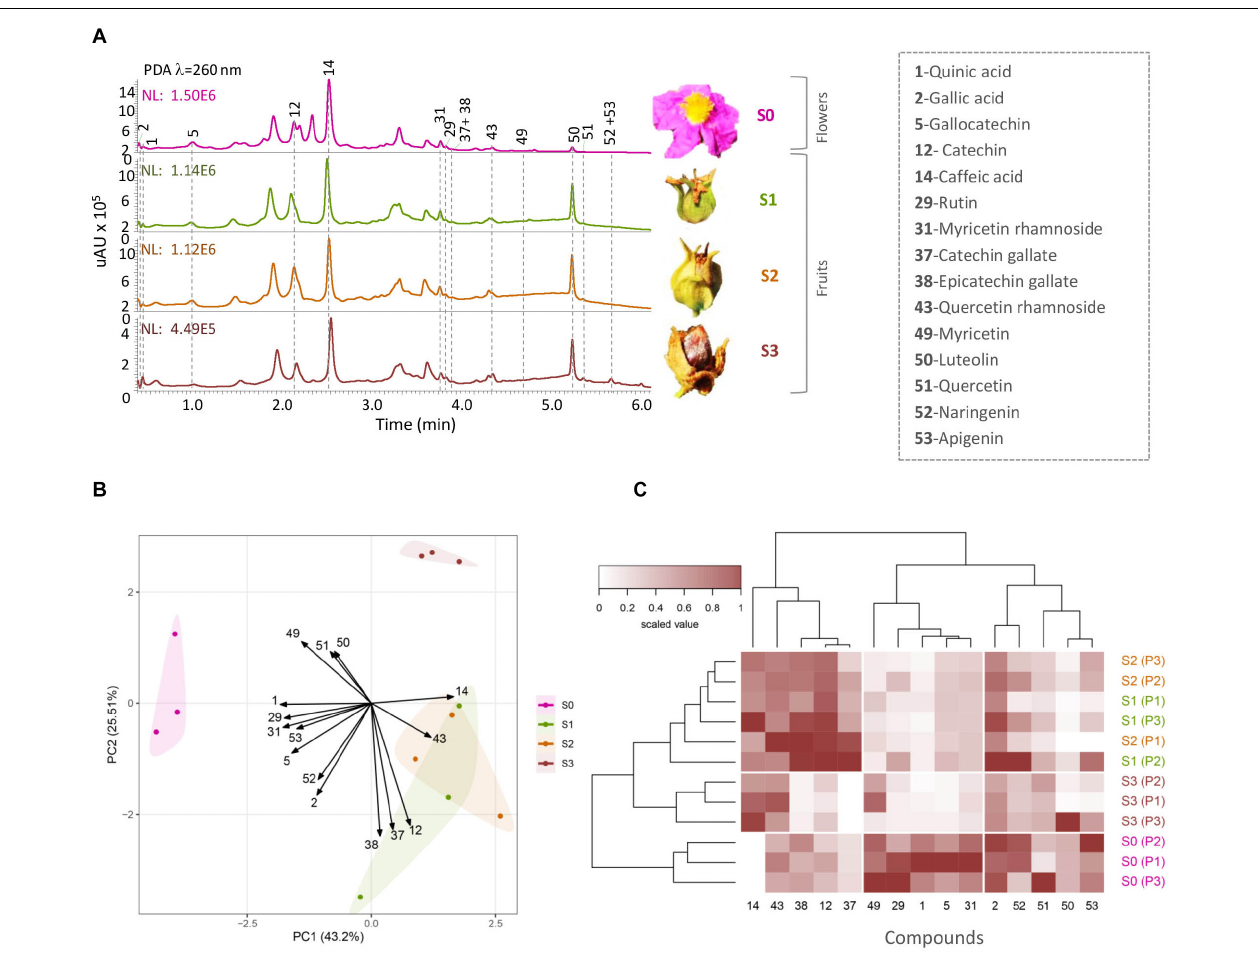
FIGURE 2 | Metabolic profiling of Cistus flower (S0) and three fruit stages (S1–S3). (A) HPLC/DAD elution profiles at λ = 260 nm; notable peaks are denoted in the legend on the side. The Y -axis scales are different for each of the chromatograms. (B) Biplot of principal component analysis performed on zero-centered and unit-scaled compound quantity data. The samples are colored by stage (S0–S3) as shown in the legend, and these groups are further encircled by a convex hull of the same color. Variable loadings are indicated by arrows and were scaled by multiplying with five prior graph constructions so they could be seen more readily. (C) Heat map of zero-centered and unit-scaled compound quantity data. The samples (in rows) are arranged according to hierarchical cluster analysis (Ward’s method of cluster agglomeration) constructed using Euclidean distances (left tree), and the metabolites (in columns) are arranged according to hierarchical cluster analysis (cluster agglomeration using complete linkage) constructed using Spearman correlation distances (top tree).